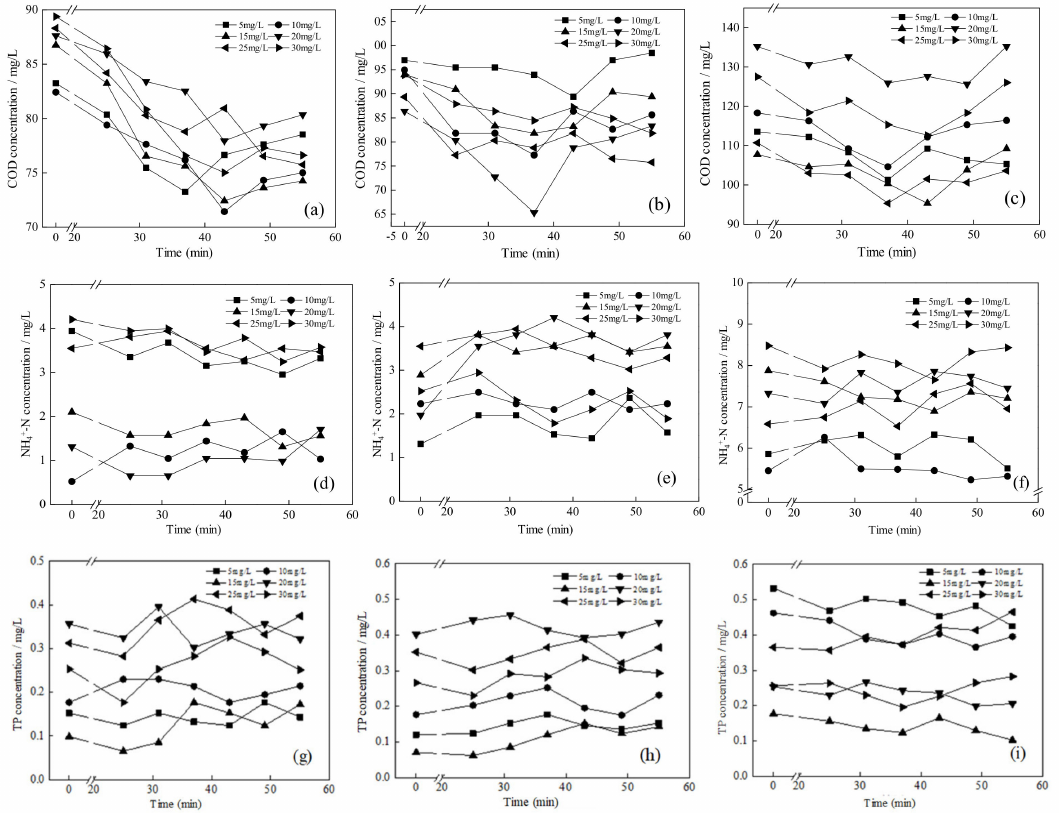
Figure 4. The variation of NH 4 + -N, TN and TP concentrations for post-ozone treatment: ( a , d , g ) 10% PW; ( b , e , h ) 30% PW; and ( c , f , i ) 50%